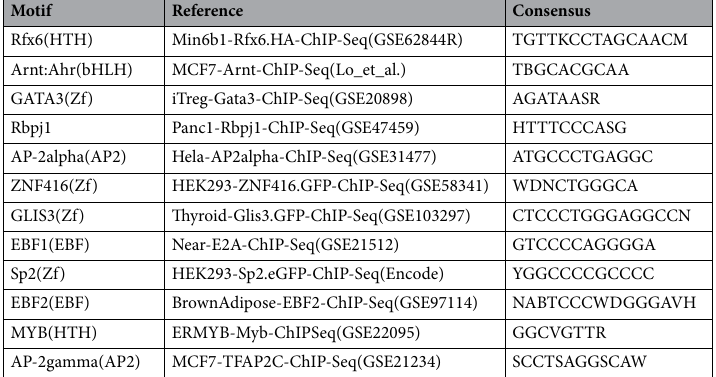
Table 1. Candidates genes that may regulate EPO transcription under hypoxic